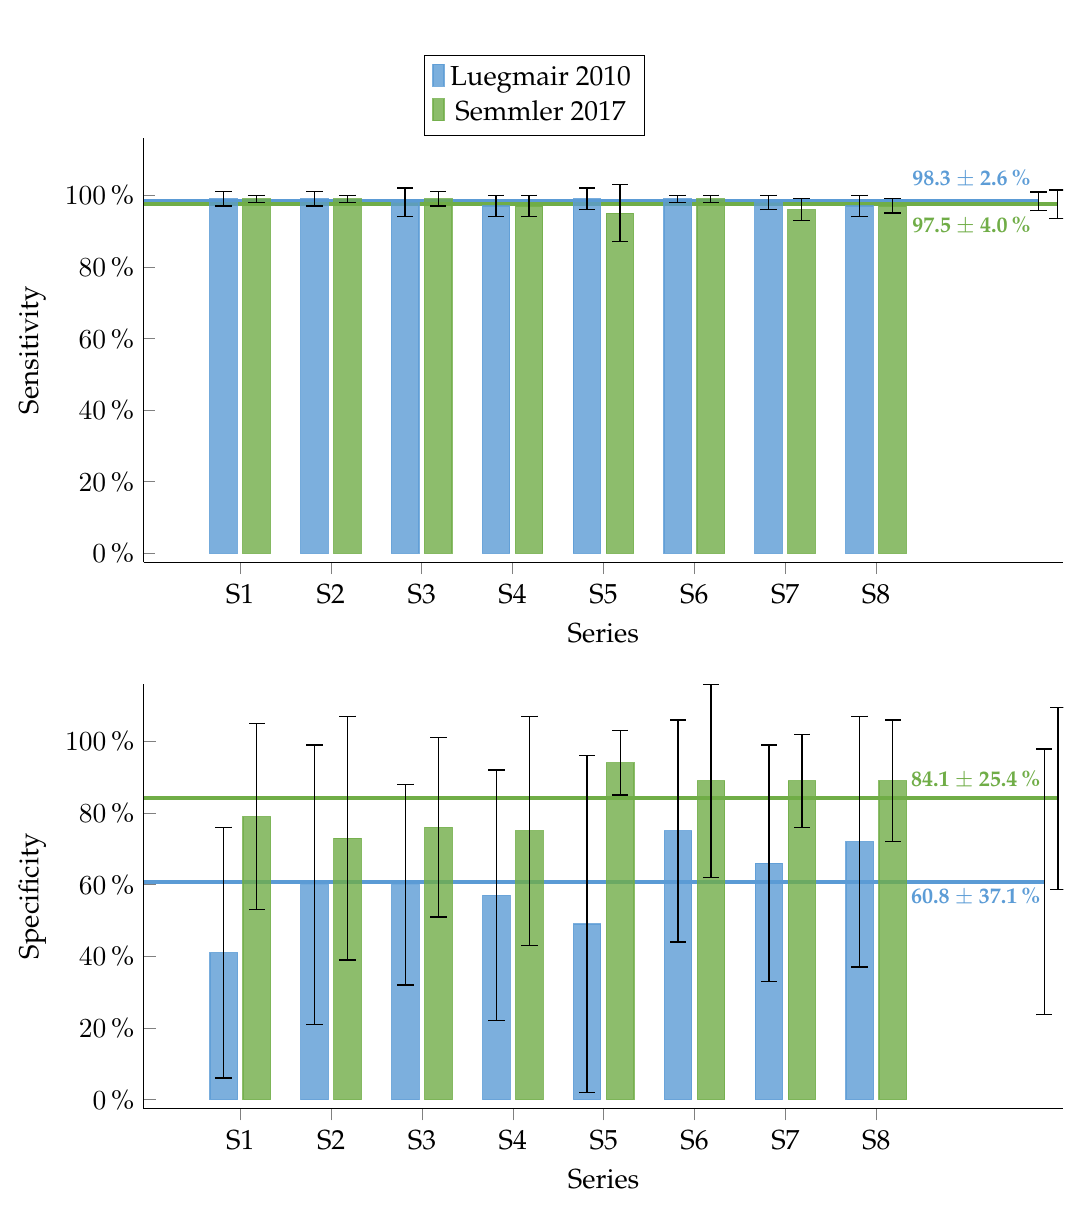
Figure 15. Evaluation of the automated laser point tracking algorithm compared to its previous version by [20] including the sensitivity ( top ) and the specificity ( bottom ). The depicted bars represent the average value for each series while the vertical error bars indicate the standard deviation within each series. The horizontal lines represent the average value over all frames of all series and the error bars indicate the corresponding standard